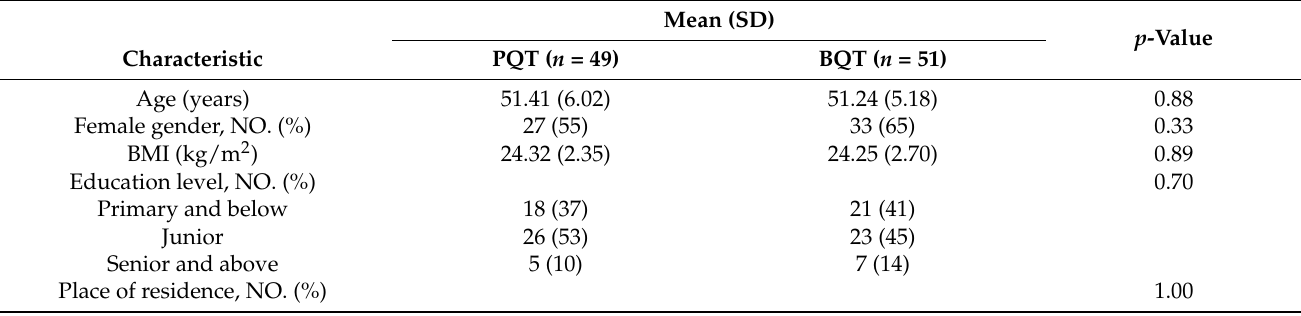
Table 1. Baseline demographic and clinical